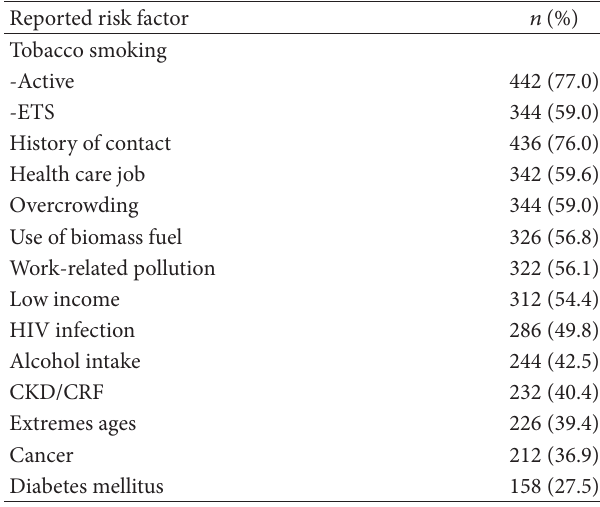
T 4: Awareness of the risk factors for TB in the